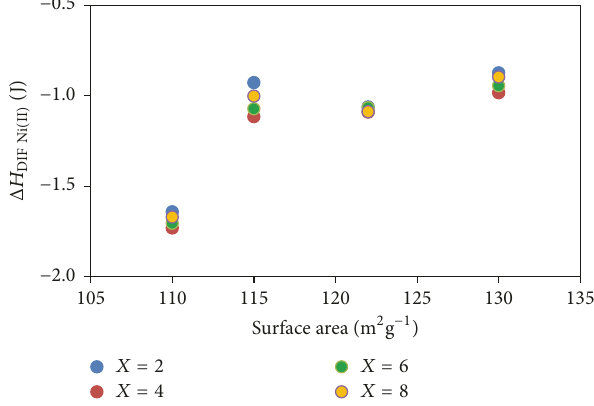
Figure 6: Ion Ni(II) differential enthalpy change, Δ𝐻 DIF Carboxylic groups content, (b) total acidity.